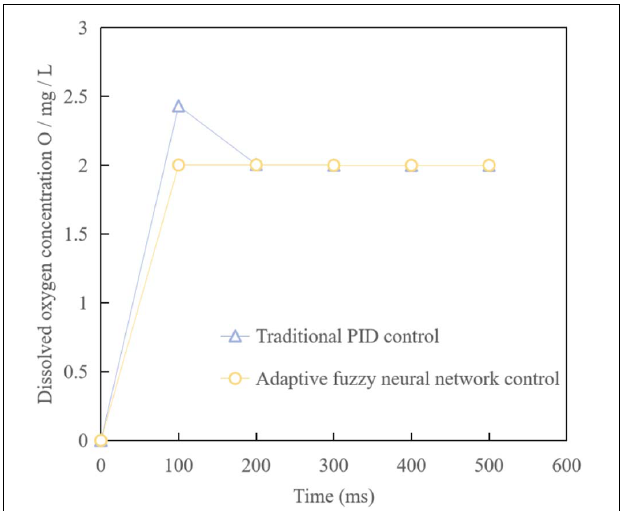
FIGURE 10 | Output control curve of dissolved oxygen